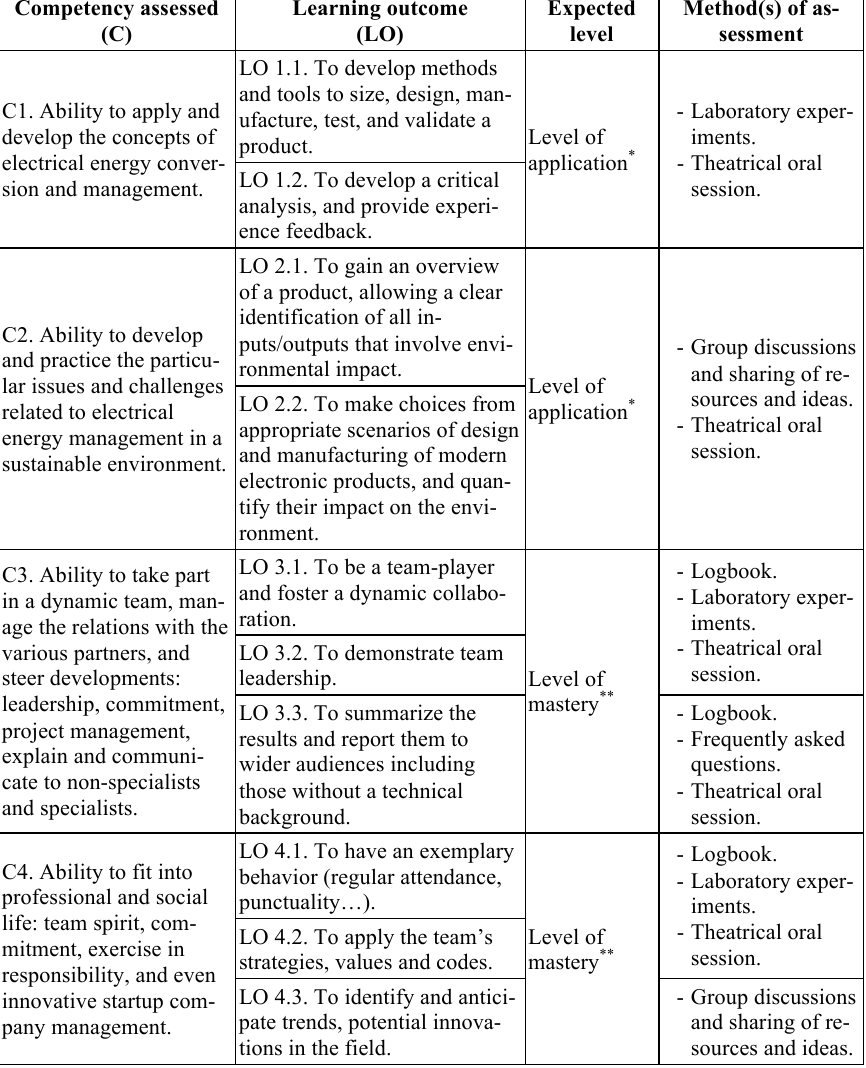
Table 1. Competencies assessed, learning outcomes, methods of assessment Competency